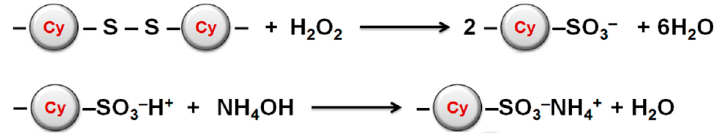
Figure 3. FTIR spectra of wool-based fibers: ( a ) pristine wool fibers; ( b ) oxidized wool fibers.